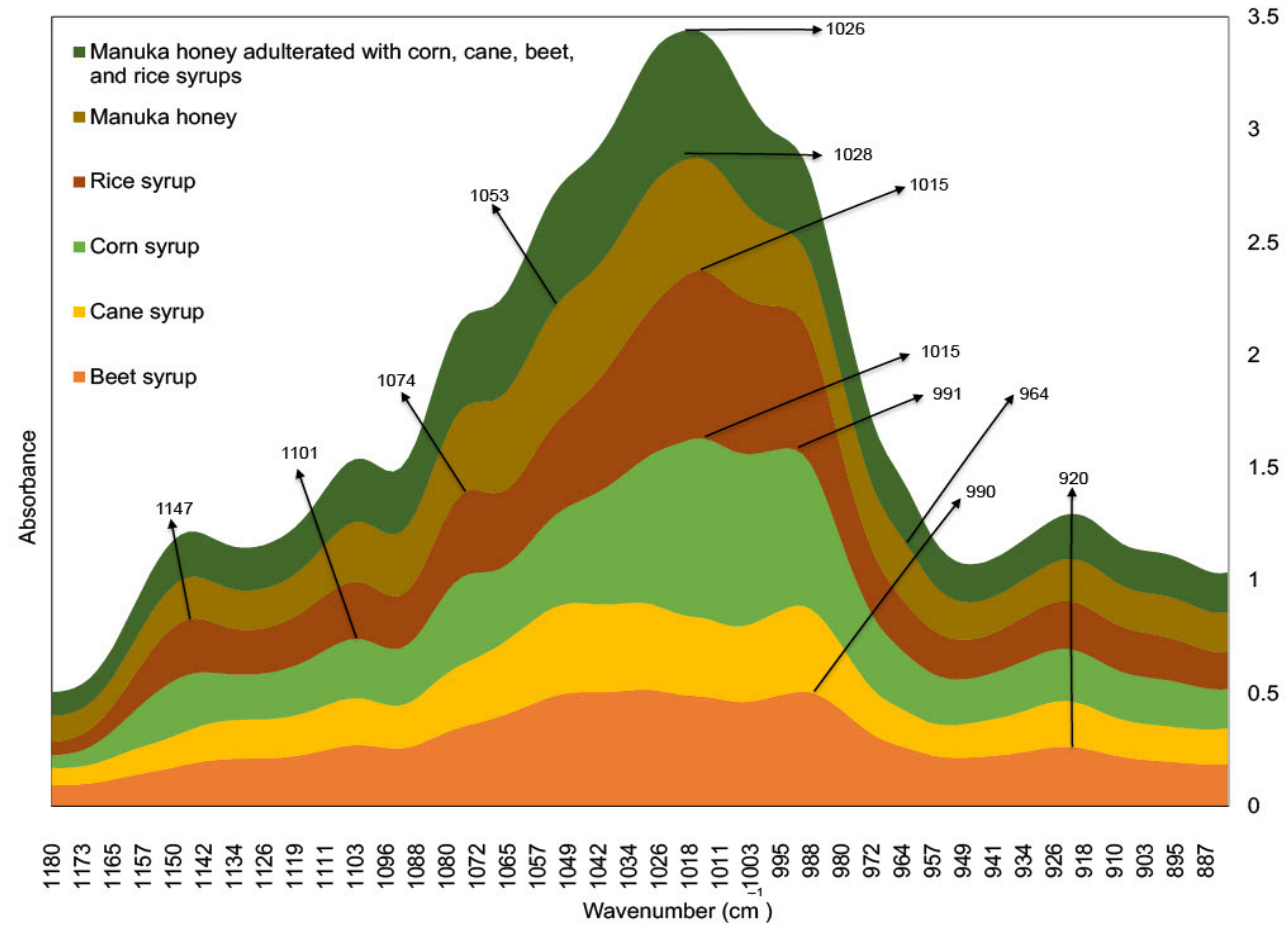
Figure 3. Fourier transform infrared spectra of syrup adulterants (i.e., corn, cane, beet, and rice), standard Manuka honey, and standard Manuka honey adulterated with corn, cane, beet, and rice syrups.